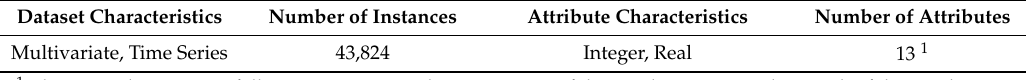
Table 4. Di ff erent models for prediction of heating zone 1.